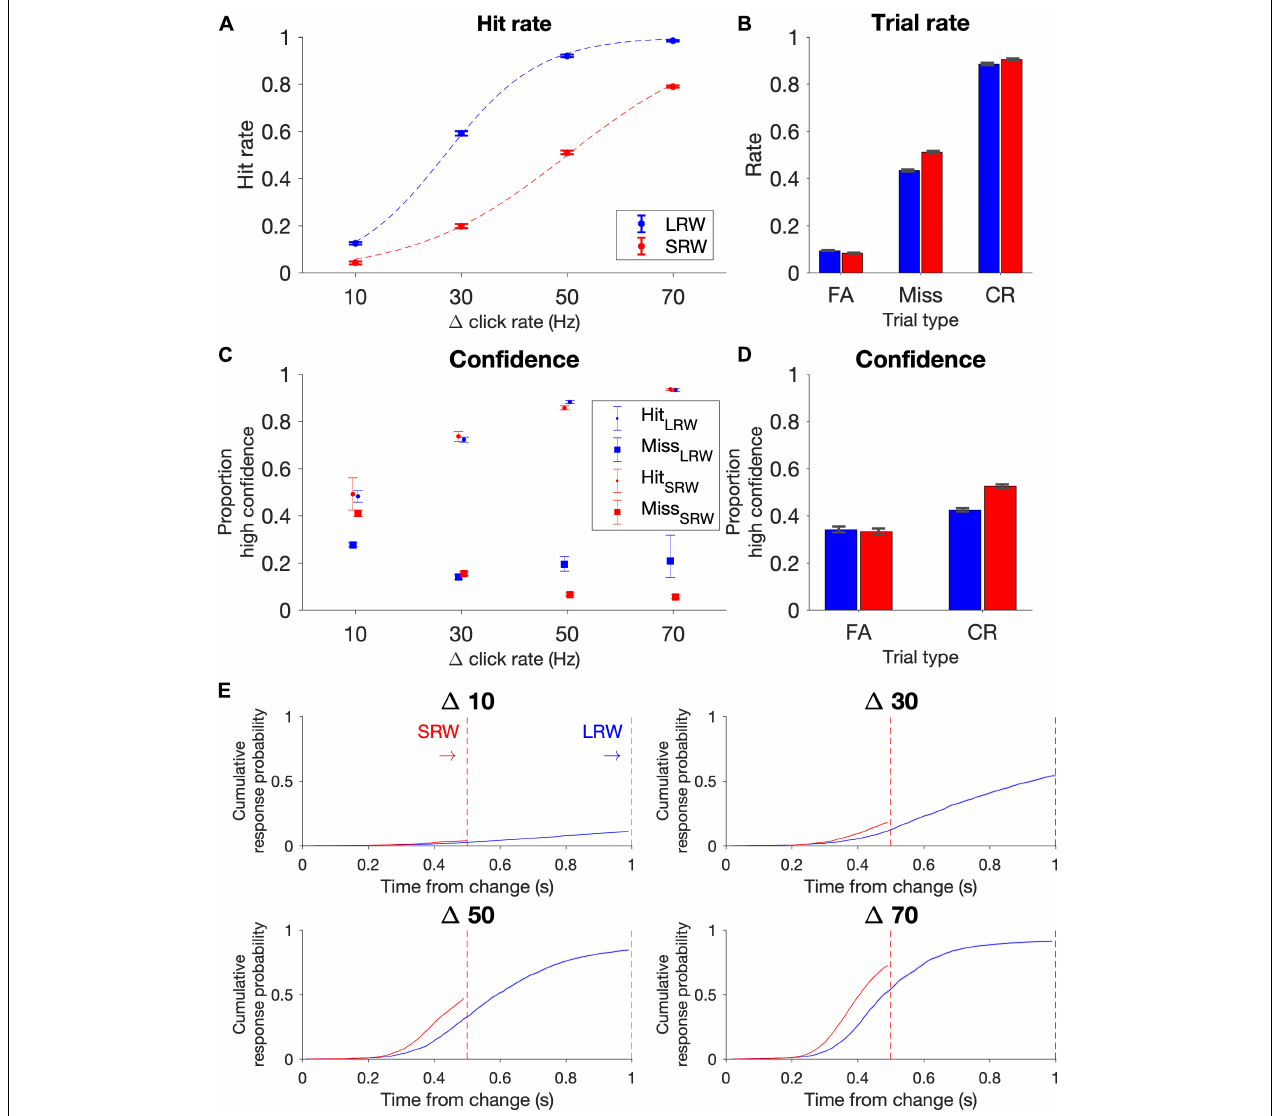
FIGURE 2 | Task performance (combined N = 11 subjects). (A) Psychometric functions on the task conditions as delineated by hit rate vs change magnitude. Data points were fit by a logistic function (dashed lines). Note that the proportion of (cid:49) s differed in the two conditions to try to match task difficulty, with probabilities for (cid:49) s 10, 30, 50, and 70 Hz in the LRW condition 0.35, 0.28, 0.22, 0.15, and in the SRW condition 0.13, 0.21, 0.29, 0.37, respectively. (B) Rate of trial outcomes in the two conditions. (C) Proportion of high confidence reports on hit and miss trials as a function of change magnitude ( (cid:49) ). (D) Proportion of high confidence reports on FA and CR trials. (E) Reaction times separated by (cid:49) are plotted as the cumulative response probability as a function of the time from the change. Error bars indicate standard error of